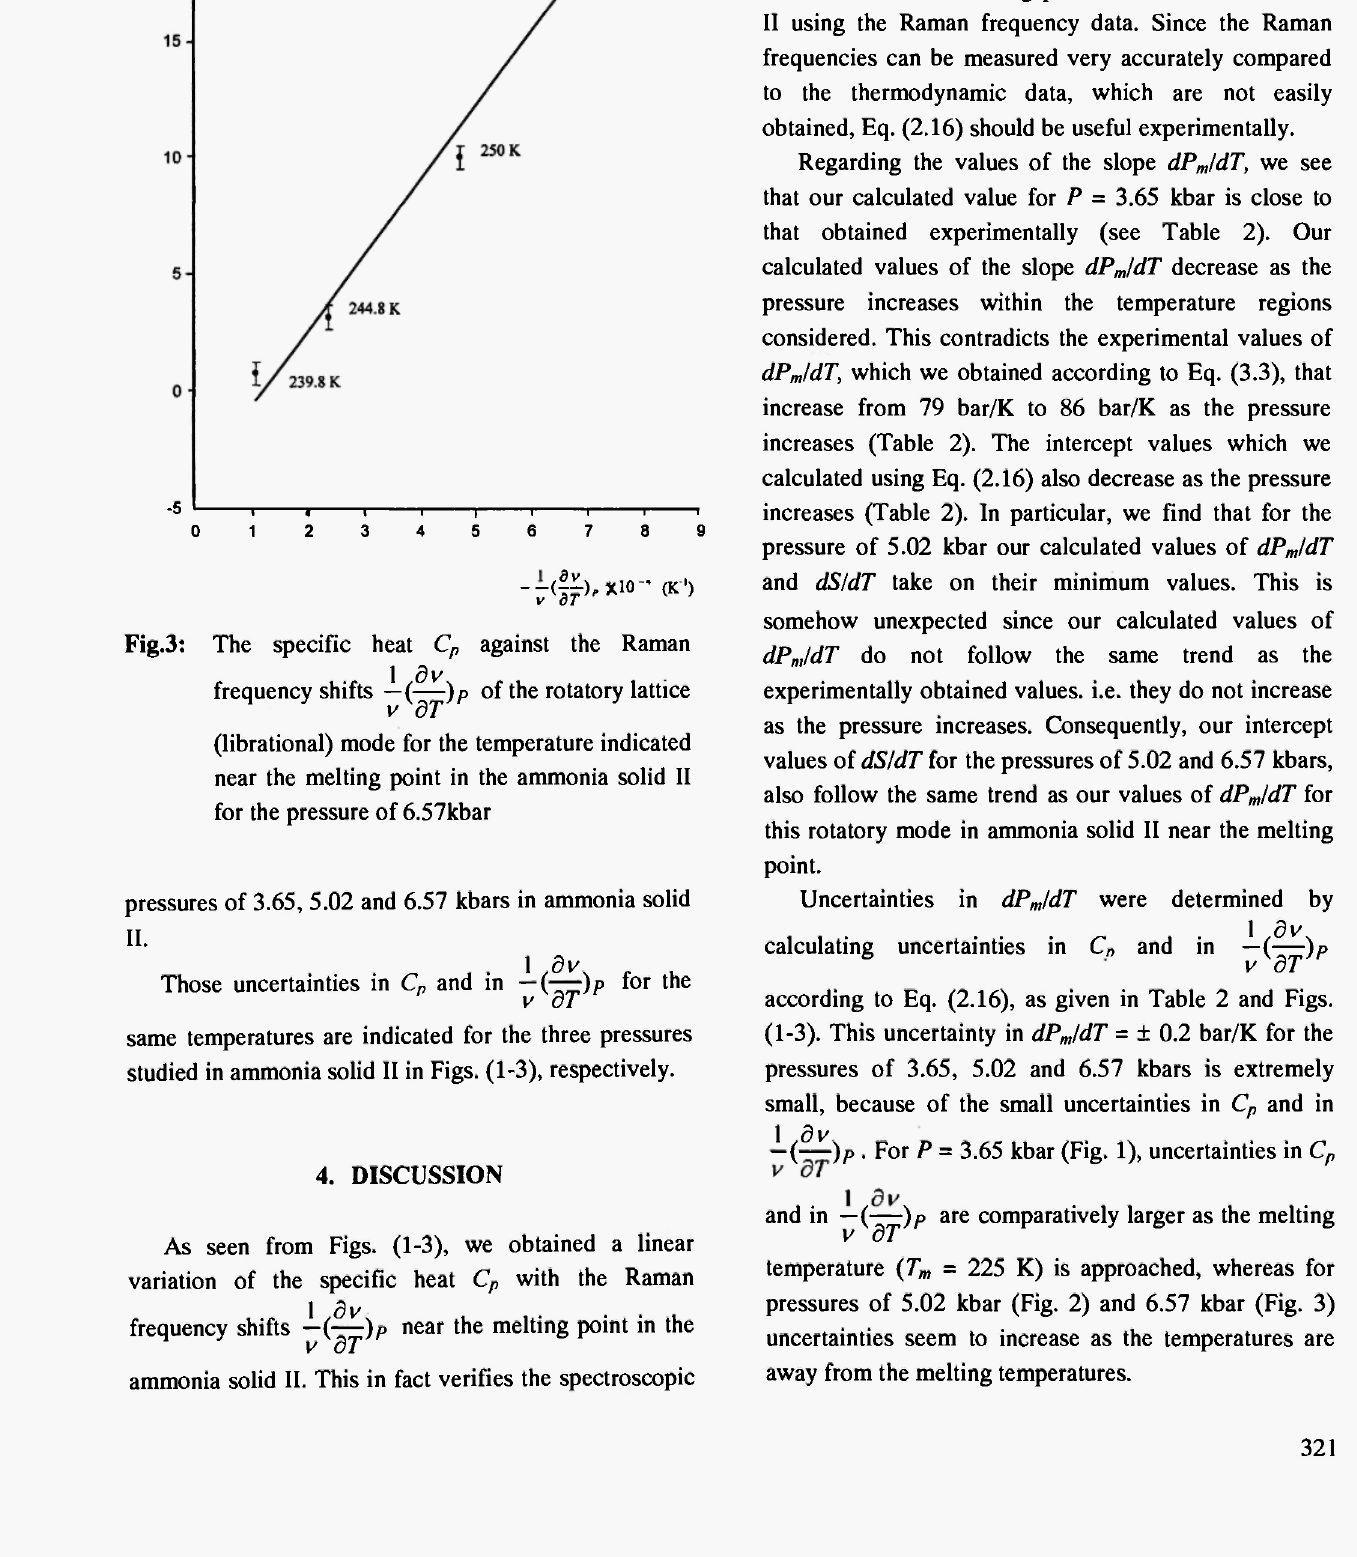
to the thermodynamic data, which are not easily obtained, Eq. (2.16) should be useful experimentally. Regarding the values of the slope dPJdT, we see that our calculated value for Ρ = 3.65 kbar is close to that obtained experimentally (see Table 2). Our calculated values of the slope dP m /dT decrease as the pressure increases within the temperature regions considered. This contradicts the experimental values of dPJdT, which we obtained according to Eq. (3.3), that increase from 79 bar/K to 86 bar/K as the pressure increases (Table 2). The intercept values which we calculated using Eq. (2.16) also decrease as the pressure increases (Table 2). In particular, we find that for the pressure of 5.02 kbar our calculated values of dPJdT and dSldT take on their minimum values. This is somehow unexpected since our calculated values of Fig.3: The specific heat C p against the Raman dP n JdT do not follow the same trend as the 1 dv experimentally obtained values, i.e. they do not increase frequency shifts — ( — ) P of the rotatory lattice ν dT as the pressure increases. Consequently, our intercept (librational) mode for the temperature indicated values of dS/dTiox the pressures of 5.02 and 6.57 kbars, near the melting point in the ammonia solid II also follow the same trend as our values of dPJdT for for the pressure of 6.57kbar this rotatory mode in ammonia solid II near the melting point. pressures of 3.65, 5.02 and 6.57 kbars in ammonia solid II. 1 dv ν dT Those uncertainties in C„ and in — ( — ) P for the according to Eq. (2.16), as given in Table 2 and Figs. ν dT (1-3). This uncertainty in dPJdT = ± 0.2 bar/K for the same temperatures are indicated for the three pressures pressures of 3.65, 5.02 and 6.57 kbars is extremely small, because of the small uncertainties in C p and in 1 dv ~(—)p · For Ρ = 3.65 kbar (Fig. 1), uncertainties in C p and in —(——)/> are comparatively larger as the melting ν dT temperature (T m = 225 K) is approached, whereas for pressures of 5.02 kbar (Fig. 2) and 6.57 kbar (Fig. 3) uncertainties seem to increase as the temperatures are away from the melting